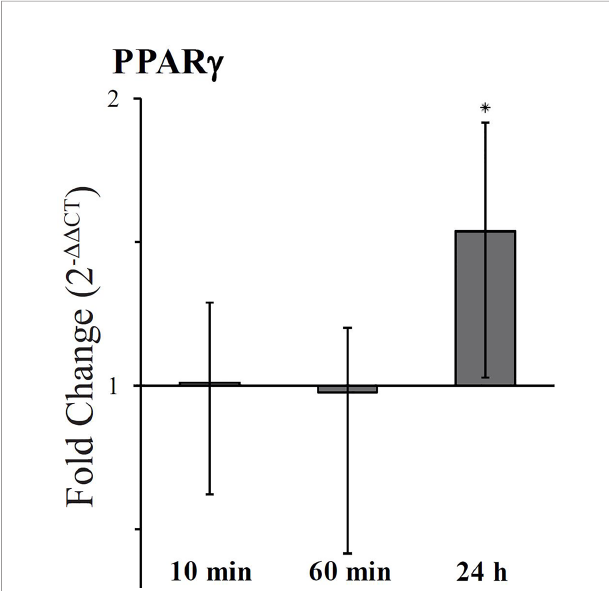
( Figure 6 ). No immediate response was observed for PPAR g 2 (10 min and 1 h), however a signi fi cant upregulation (P<0.05) was observed after 24 h.